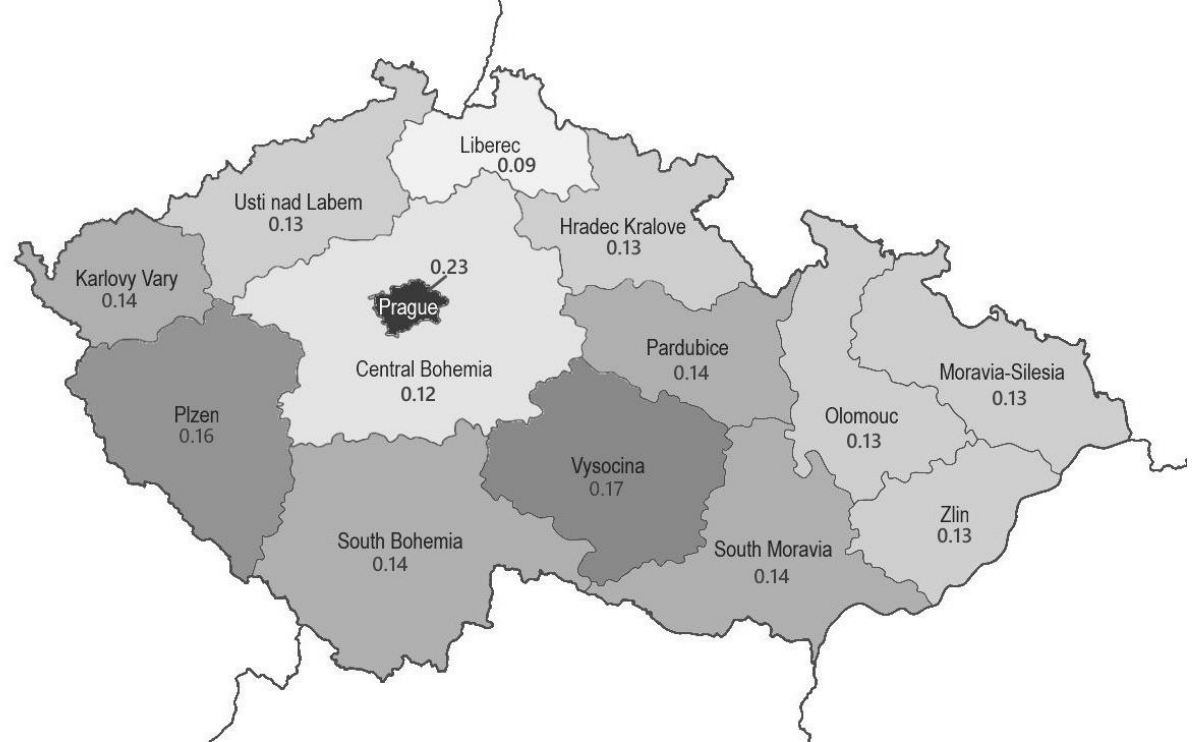
Figure 3. The incidence map of TSEs in individual regions of the Czech Republic. For each region, the number of cases per 100,000 population per year is indicated.